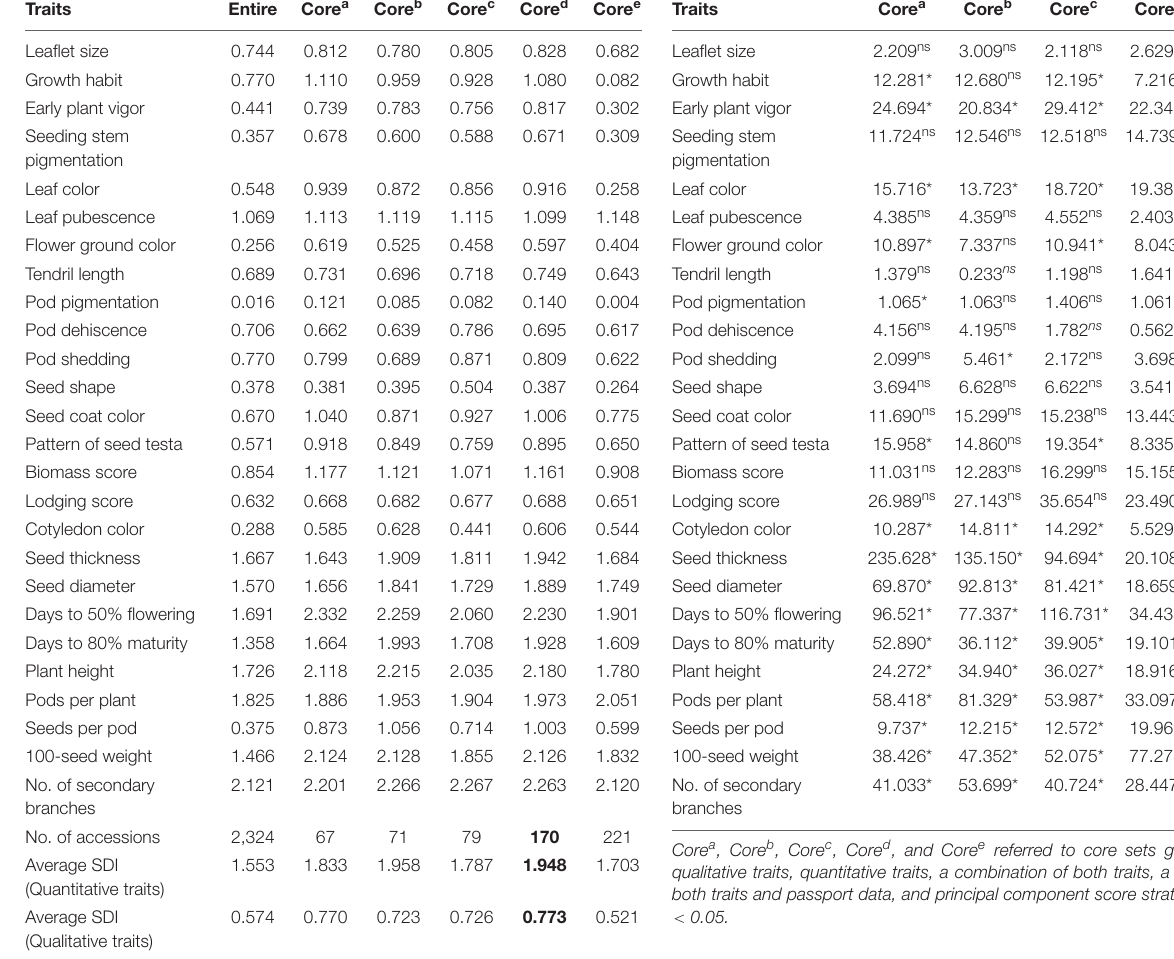
TABLE 3 | Chi-square test for comparison of frequency distribution for descriptor traits studied in lentil core sets derived from different datasets and strategies.